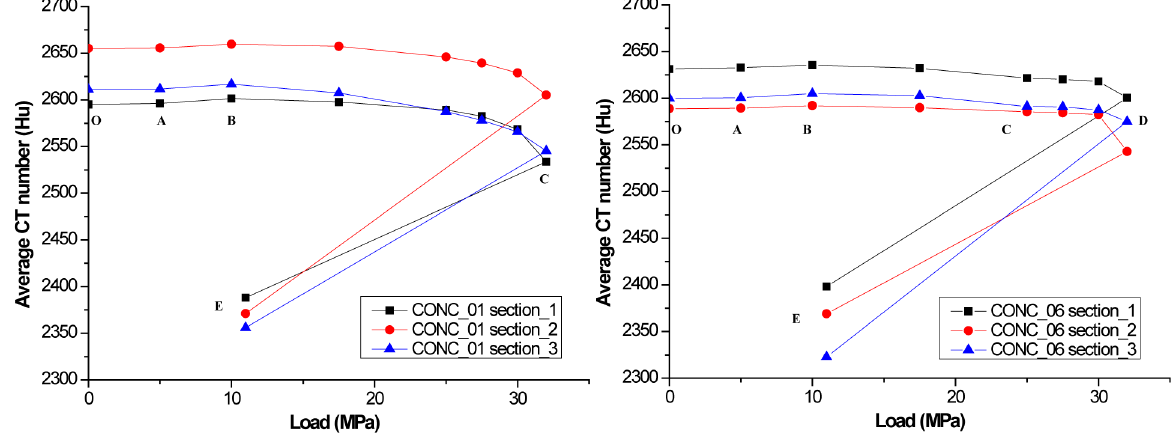
Fig. 6. Load-average CT number curves of the static (left) and dynamic (right)